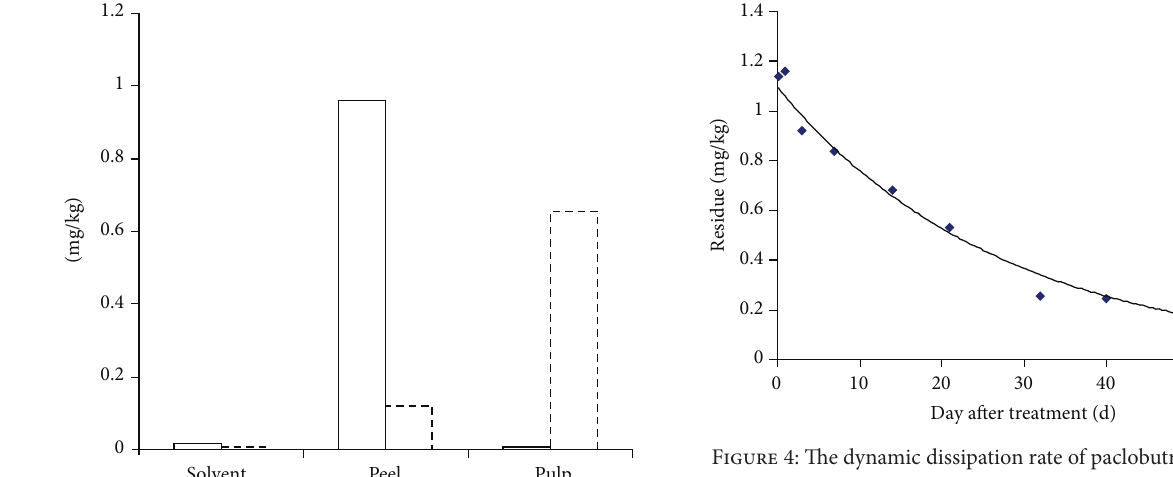
in potato and soil using UHPLC-MS/MS. The optimal chromatographic separation and sensitivity were successfully applied to the analysis of paclobutrazol residue in potato and soil. According to risk assessment with NEDI and ADI, a MRL of paclobutrazol was recommended as 1.0